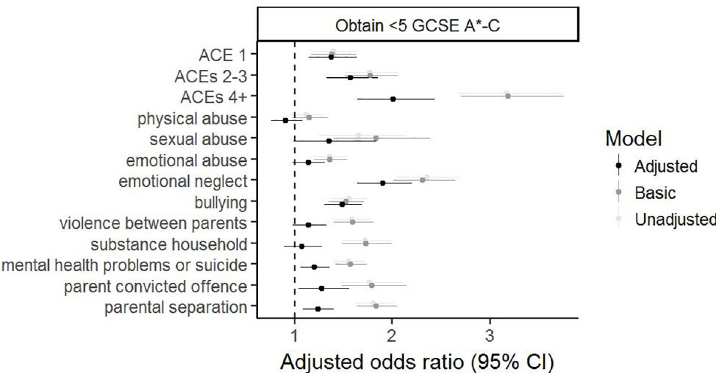
Fig 1. Forest plot for the associations of the ACE score and separate ACEs with obtaining fewer than 5 GCSEs at A � –C, including Maths and English. The reference category for each category of the ACE score (1, 2–3, and 4+) is experiencing 0 ACEs. The basic model is adjusted for sex. The adjusted model additionally includes home ownership, maternal and partner education, household social class, parity, ethnicity, maternal age, maternal marital status, and maternal and partner depression during pregnancy. GCSEs are qualifications obtained at age 16, which was the end of compulsory education for this cohort. ACE, adverse childhood experience; CI, confidence interval; GCSE, General Certificate of Secondary Education.